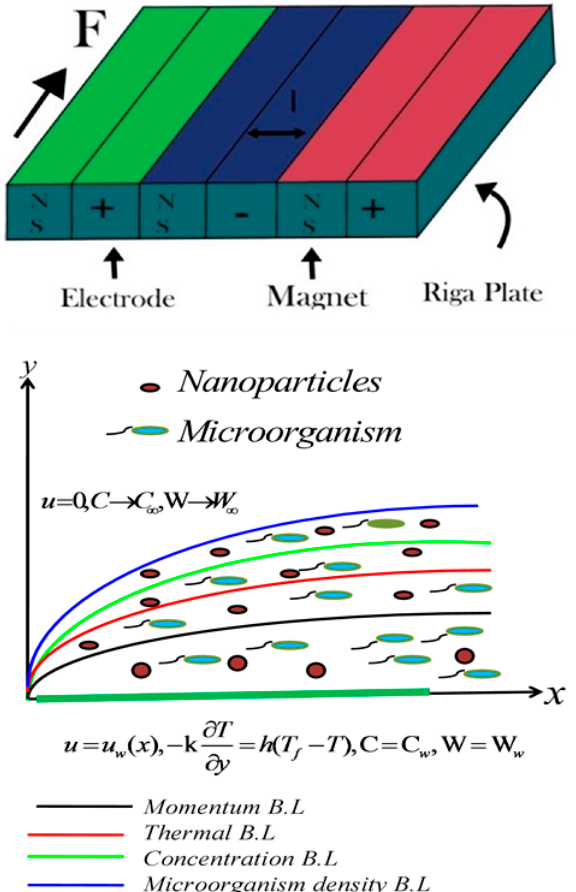
Figure 1. Physical configuration of the flow problem.